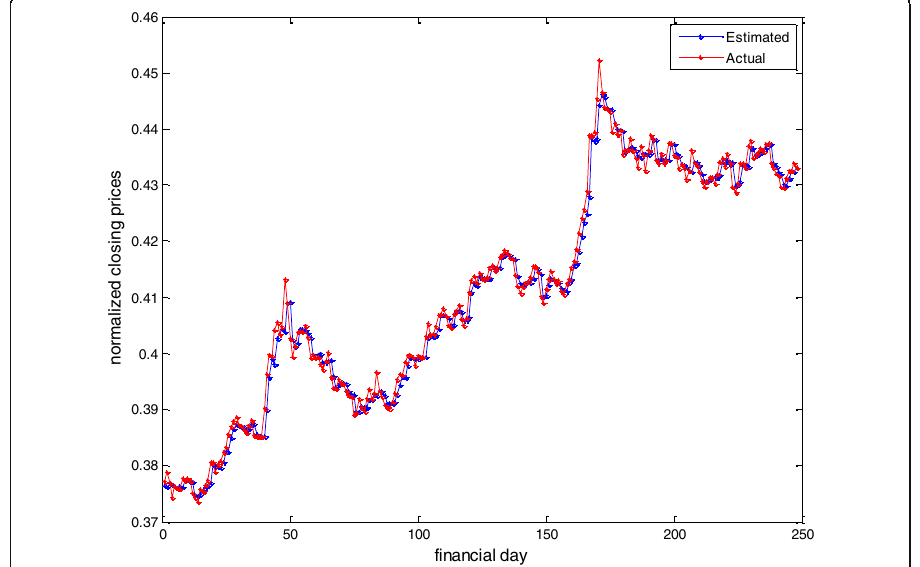
Fig. 10 Actual v/s estimated closing prices by CPNN-GA for TAIEX indices